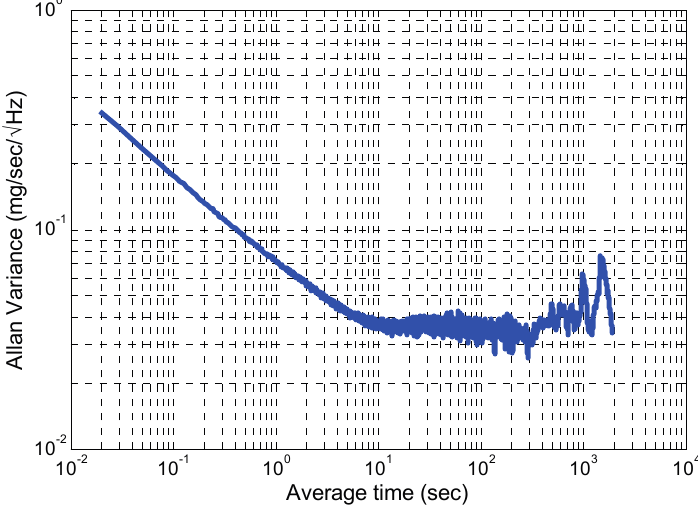
Figure 3. Allan variance of the second component of the